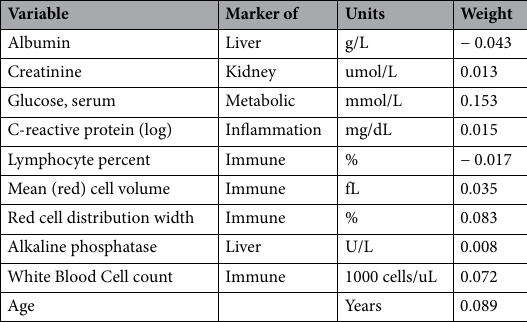
Table 2. Gompertz coefficients developed in the Rotterdam study for BioAge1: without brain markers.